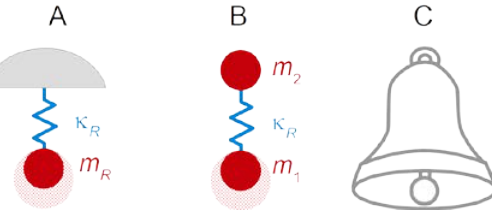
Figure 1. ( A ) The simplest possible harmonic resonator. A mass is linked to a rigid wall across a spring. The resonance frequency is ω 0 ≈ ( κ R / m R ) 1/2 . If m R increases, the resonance frequency decreases in consequence. ( B ) A resonator abandoning the rigid wall. Two masses are linked across a spring. The resonance frequency is given as ω 0 ≈ ( κ R / µ ) 1/2 , where µ is the reduced mass ( µ = m 1 m 2 /( m 1 + m 2 )). Again, increasing one of the two masses will lower the resonance frequency. The diagram in ( B ) contains discrete elements, similar to the equivalent lumped-element circuits discussed in Section 8.4. ( C ) Contrasting to the resonators in ( A , B ), the bell does not consist of discrete masses and springs. It is an elastic body with a certain shape, made from materials with a certain density and stiffness. Finding its resonance frequencies (plural) is a classical problem of acoustics. For any given resonance, one may construct an equivalent lumped-element model containing discrete elements (as in ( A ) or ( B )), which reproduces this one resonance. In principle, one might tune the bell by gluing weights to its rim. The common practice rather is to remove metal in annular rings, usually from the inside [14]. That changes both the effective mass and the effective spring constant. The focus then is not usually on the absolute frequency of the fundamental mode, but rather on the ratios between the overtone frequencies and the fundamental frequency. These ratios govern the perception of the bell’s sound.